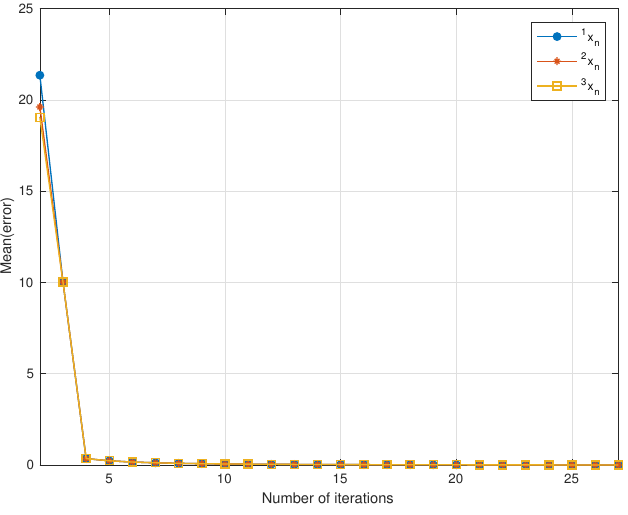
Figure 2. Computation results for Example